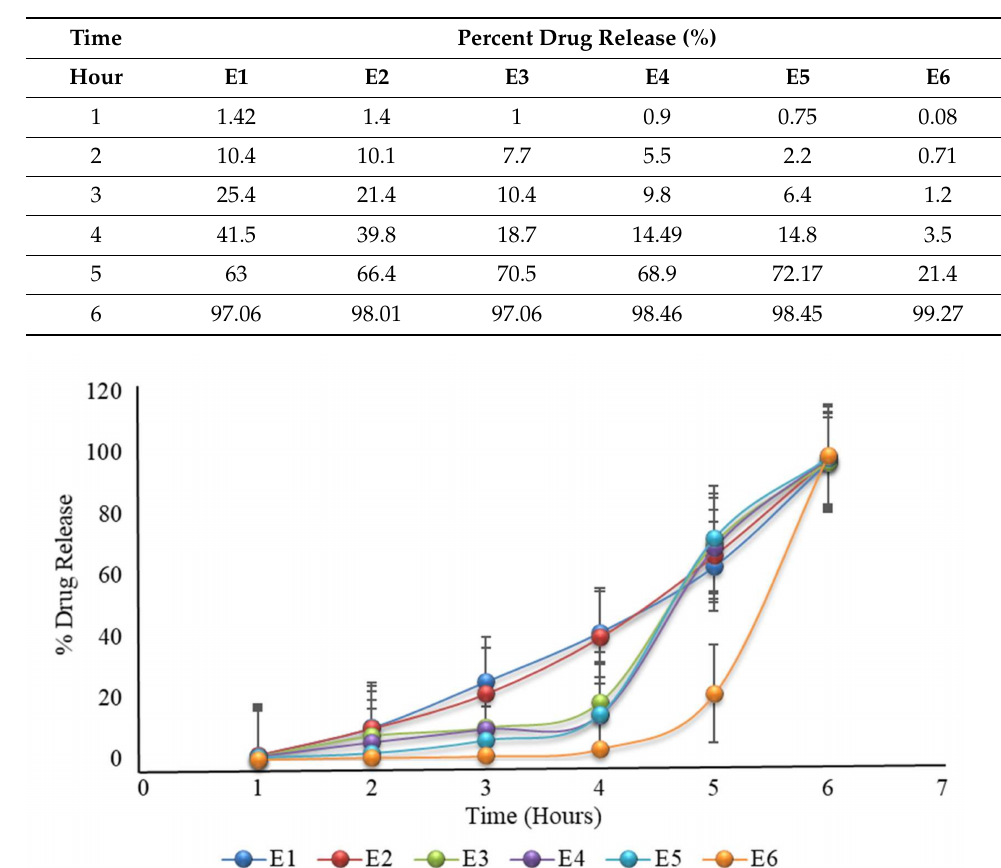
Table 9. The in vitro dissolution of formulation E1 to E6 (the first 2 h in an acidic medium of pH 1.2, then in a phosphate buffer medium of pH 6.8).